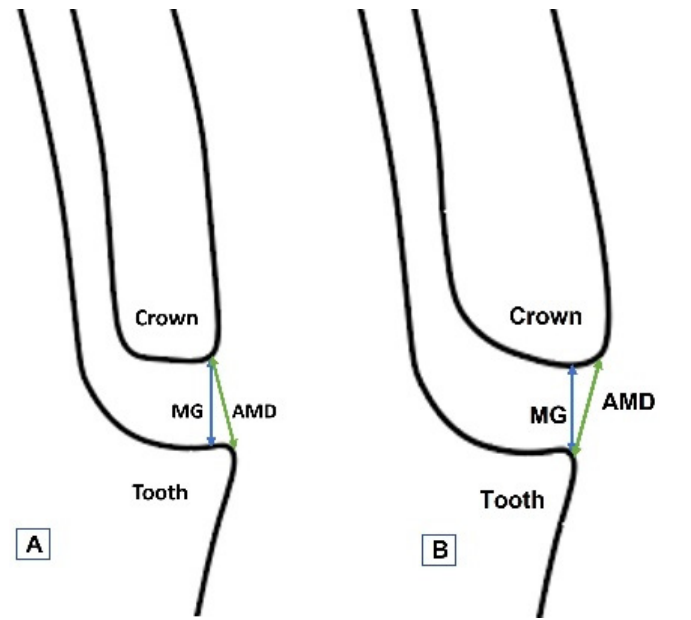
Figure 4. Schematic diagram showing the MG and AMD measurement scheme at the crown-abutment junction for undercontoured ( A ) and overcontoured ( B ) crowns.